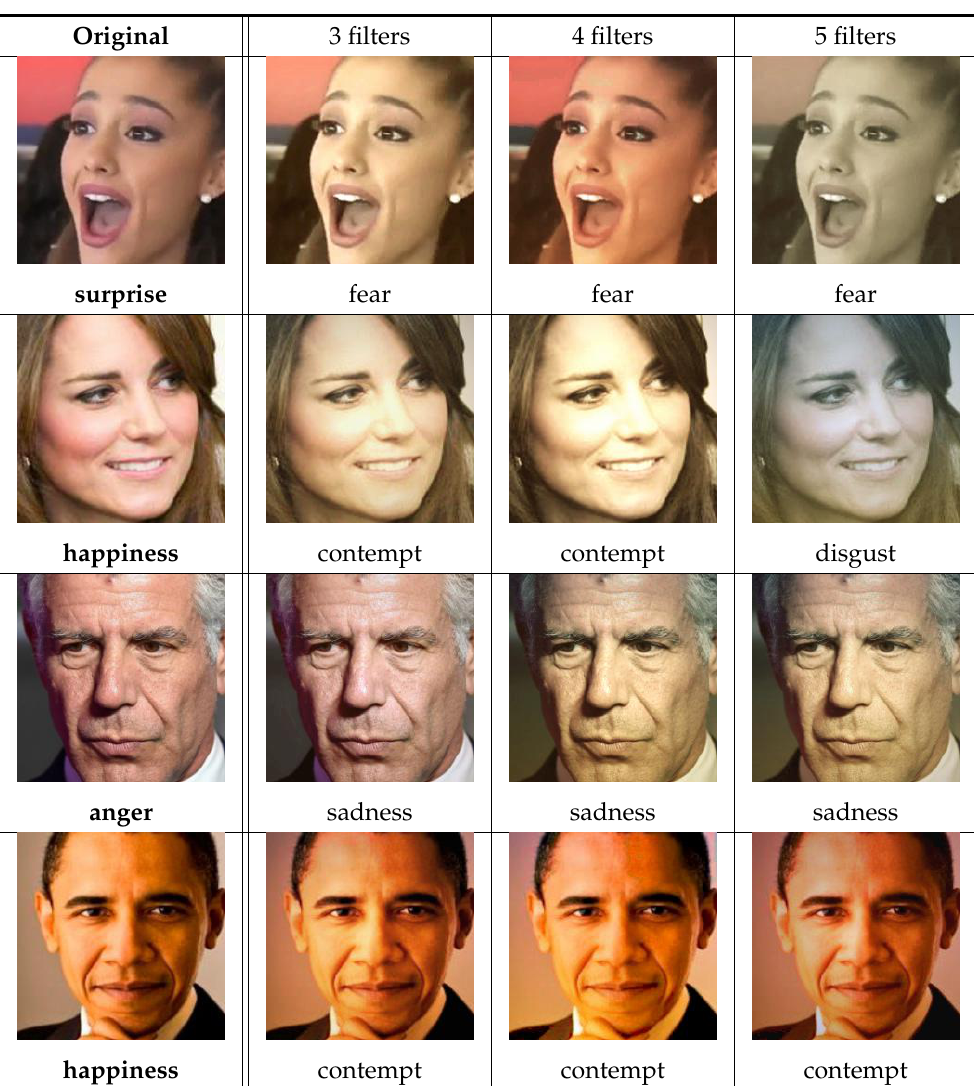
Table 1. Examples of adversarial samples: the first column reports the original image and original classification. Columns 2–4 show the adversarial images with their classification. We can notice how the adversarial attack changes the automated emotion recognition without disrupting the image